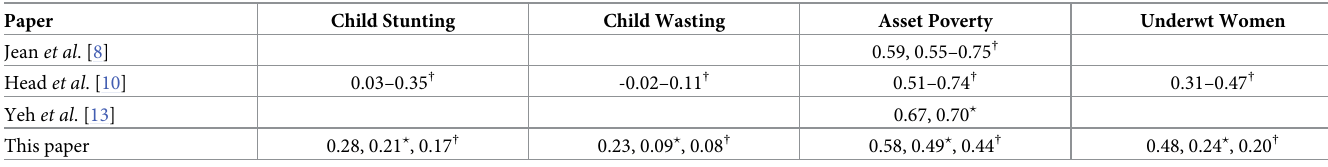
Unmarked, ? , and † flagged r 2 values represent aggregate, mean country, and mean survey level, results respectively. Note that Head et al . [10] reports predictive performance for child weight for height percentage and child height percentile, which are not directly comparable to our wasting or stunting metrics, and we estimate their performance on the latter from a